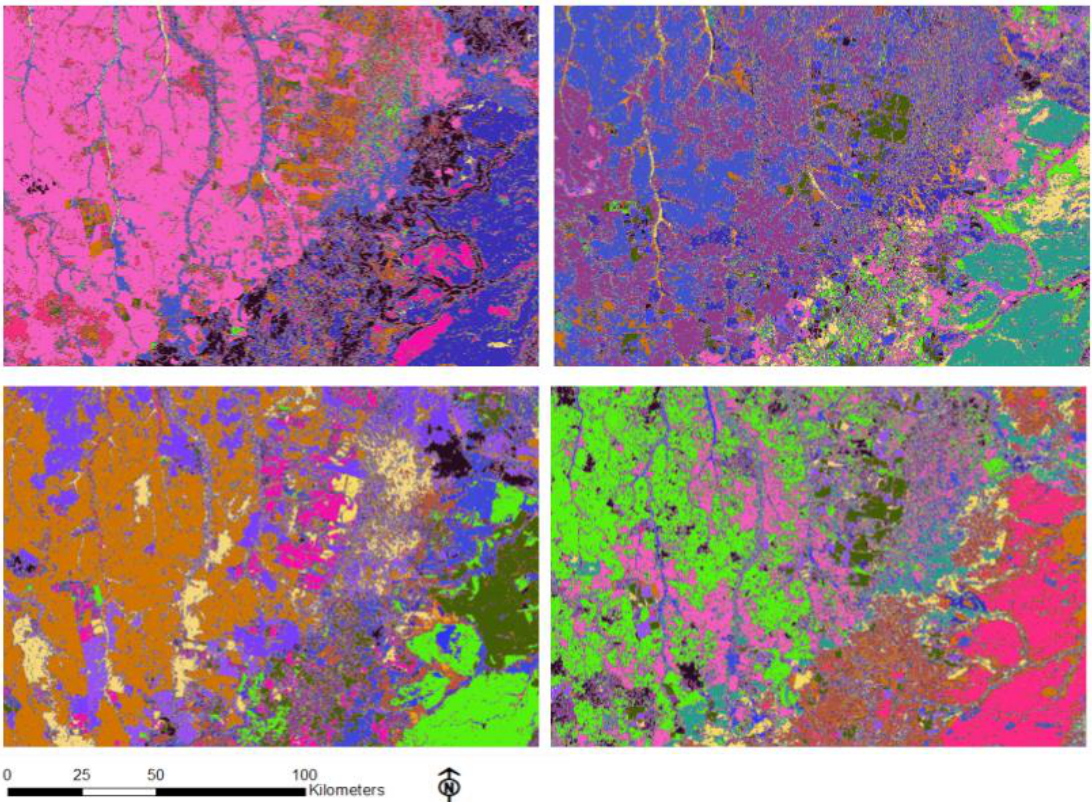
Figure 3. Unsupervised Landsat classifications from four dates in the mid-1980s, used as inputs in BULC-U for fusing Landsat and GlobCover data as described in the text.